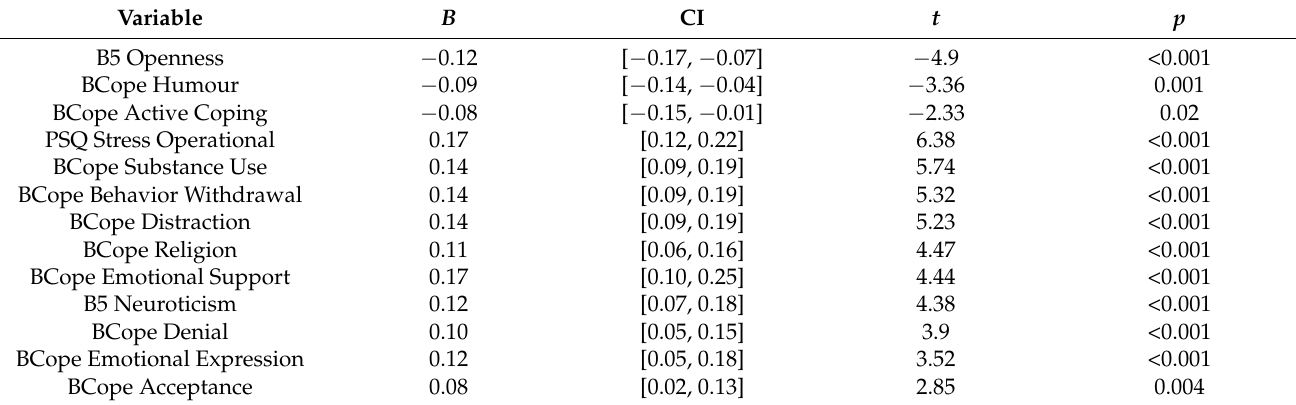
Table 3. Linear multiple regression results for the prediction of total IES-R PTSD